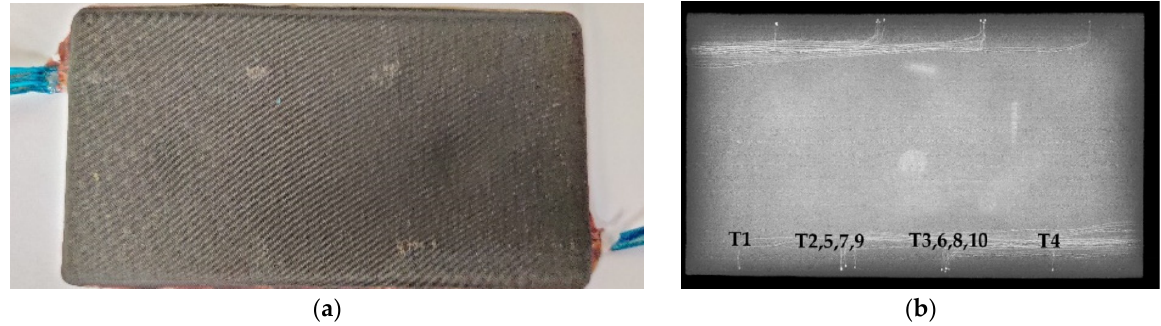
Figure 2. ( a ) Example of a coupon that is bolt-free after a curing process; ( b ) X-ray sample of a coupon with the white dots representing the thermocouples within the laminate.